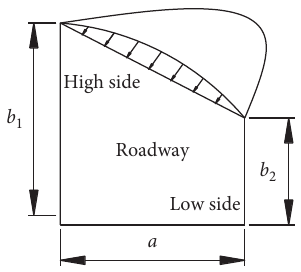
Figure 3: Stress distribution at the roof of the